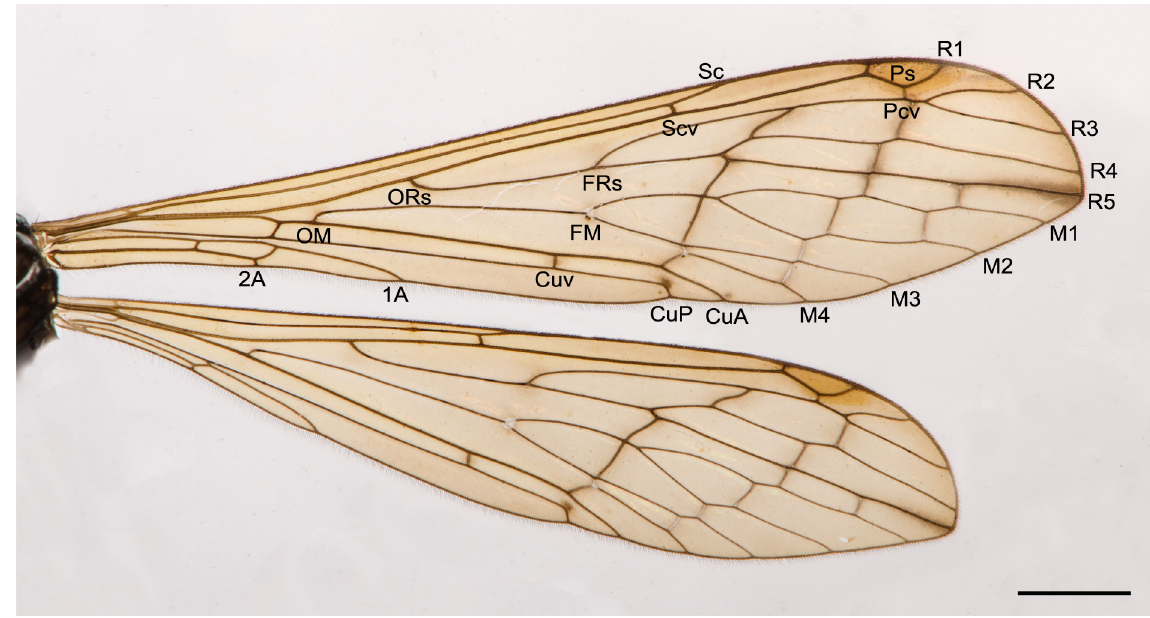
Fig. 6. Right wings of a male specimen of Terrobittacus angustus sp. nov. Scale bar = 2.0 mm.